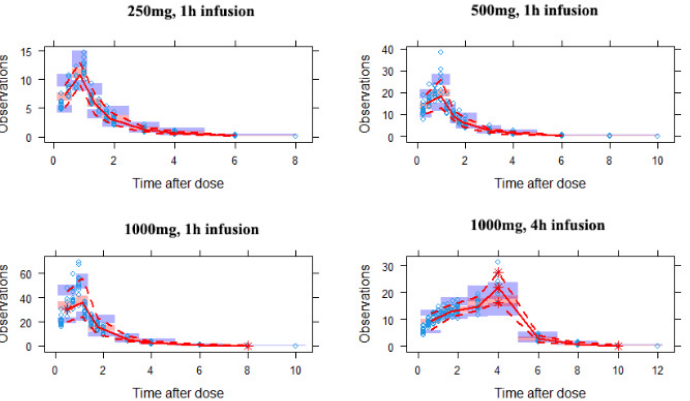
Figure 5. Visual predictive check plots for the doripenem concentration in plasma with different dosing regimens. Open circles represent observed concentrations. The red line represents the median of the observations. The red dashed lines represent the 5th and 95th percentiles of the observations. The blue shaded areas represent the 90% confidence intervals for the 5th and 95th percentiles, and the orange shaded areas represent the median of the predicted data.